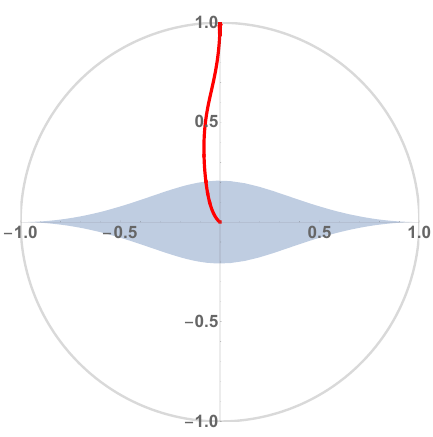
Figure 1 . The image of the map q ( z ) given in eq. (2.10) which takes us from the C parametrized by z to the unit disc in q -space. The shaded domain is the entire z plane and the red trajectory is a path along which we analytically continue the Euclidean four-point function to the desired OTO correlator plotted here for (cid:15) 1 = 0 ; (cid:15) 2 = 0 : 2 ; (cid:15) 3 = 0 : 1 ; (cid:15) 4 = 0 : 3 ; (cid:12) = x = 1 and t from 0 to 1